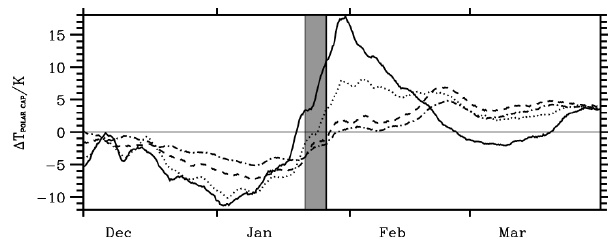
Fig. 5. Polar cap temperature (50 to 90 ◦ N) anomaly 1T POLARCAP Figure 5: Polar cap temperature (50 °N …. 90 °N) anomaly Δ T POLAR CAP at 10 hPa (solid 4 at 10hPa (solid line), 20hPa (dotted line), 50hPa (dashed line) and line), 20 hPa (dotted line), 50 hPa (dashed line) and 100 hPa (dashed-dotted line) for the 5 100hPa (dashed-dotted line) for the winter months December, Jan- winter months December, January, February, and March 2009/2010. The grey shaded area 6 uary, February, and March 2009–2010. The grey shaded area mark mark the 5 day period after the mean temperature gradient between 85 °N and 60 °N is 7 the 5 day period after the mean temperature gradient between 85 ◦ N positive and the thick solid line marks the central date of the major warming event on 26 8 and 60 ◦ N is positive and the thick solid line marks the central date January 2010. 9 of the major warming event on 26 January 2010.